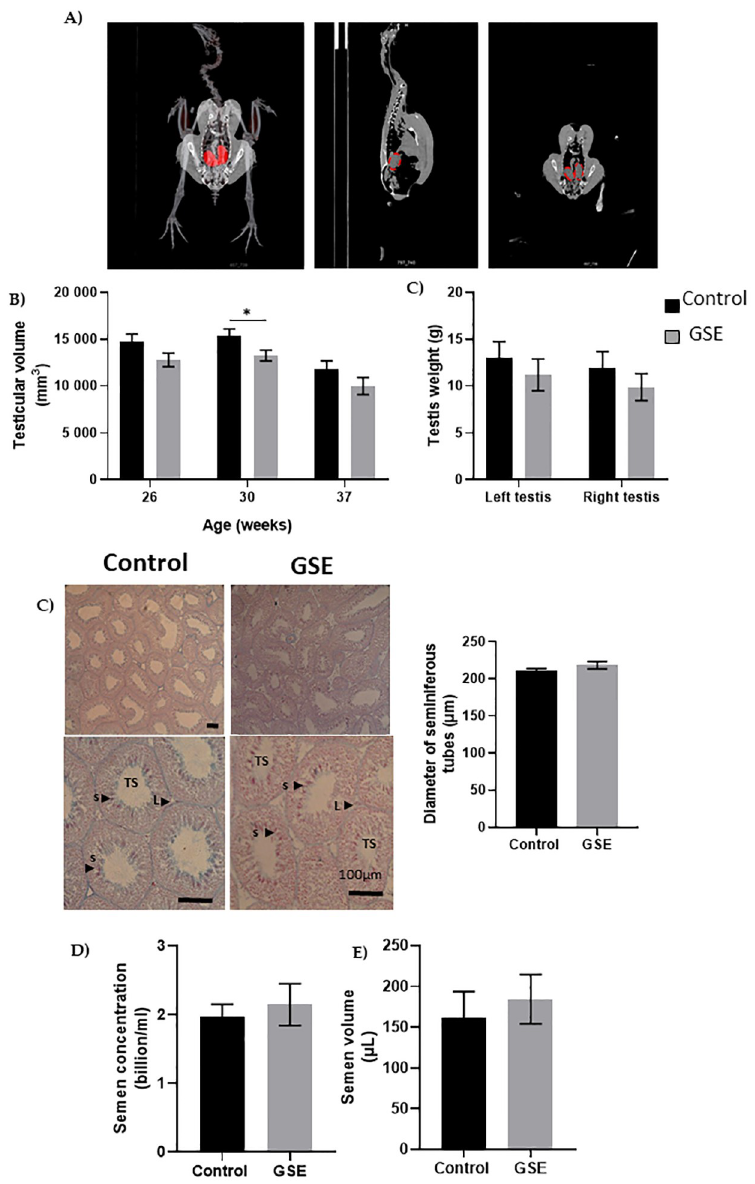
Fig 3. Testicular histology. ( A ) Representative picture of computerized tomography analysis of testes (red). (B) Volume of testes from weeks 26 to 37 (n = 10 animals) (C ) Testis weight at 37 weeks of age. (C) Representative picture of seminiferous tubule histology of 37-week-old broilers. TS, seminiferous tubules composed of germ cells and Sertoli cells; L Leydig cells; s spermatozoa. The diameter of seminiferous tubules ( μ m) is represented to the right (n = 10 per group). (D) Semen concentration (billion/ml) (n = 10 per group) and (E) semen volume ( μ L) is represented in both groups (n = 10 per group). Results are presented as means ± SEM. � , p < 0 . 05 ; ��� , p < 0 . 001